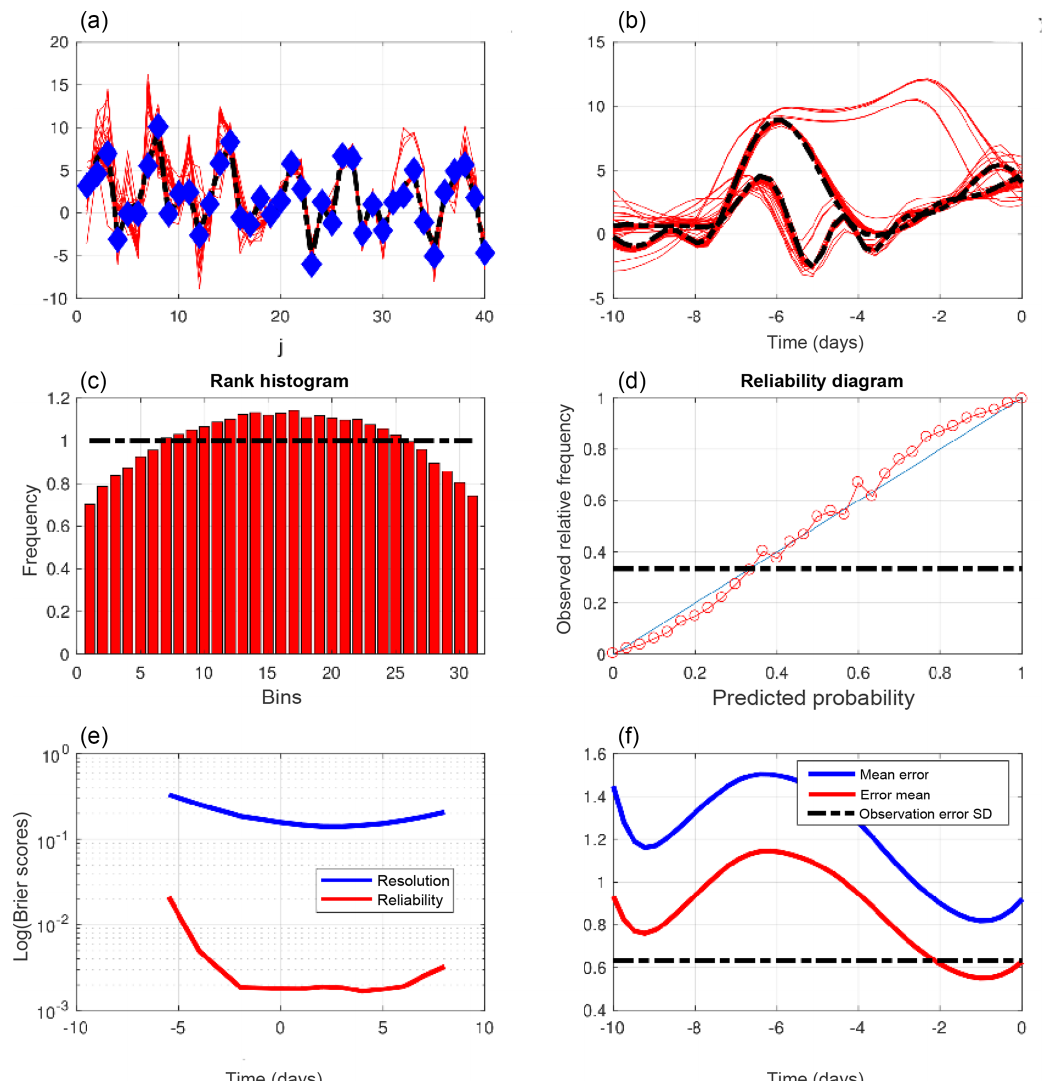
Figure 1. Diagnostics of an experiment performed in the same conditions as for Figs. I-4 and I-5, with the only difference being that the length of the assimilation windows is now 10 days. (a) Truth (dashed black curve), observations (blue dots), and minimizing solutions (red curves) at the initial time of one assimilation window, as functions of the spatial coordinate. (b) Truth (dashed curves) and minimizing solutions (red curves) as functions of time at two grid points over one assimilation window. (c) Rank histogram for the variable x over all grid points and ensemble assimilations. (d) Reliability diagram for the event { x < 1 . 14 } , which occurs with frequency 0.35 (dashed–dotted horizontal curve), built over all grid points and ensemble assimilations. (e) Components of the Brier score for the events E = { x < τ } , evaluated over all grid points and ensemble assimilations, as functions of the threshold τ (red curve: reliability, blue curve: resolution). (f) Average RMS errors to truth, as functions of time over assimilation windows. Blue curve: error in individual assimilations. Red curve: error in mean of ensembles (the black dashed–dotted curve shows the standard deviation of observational